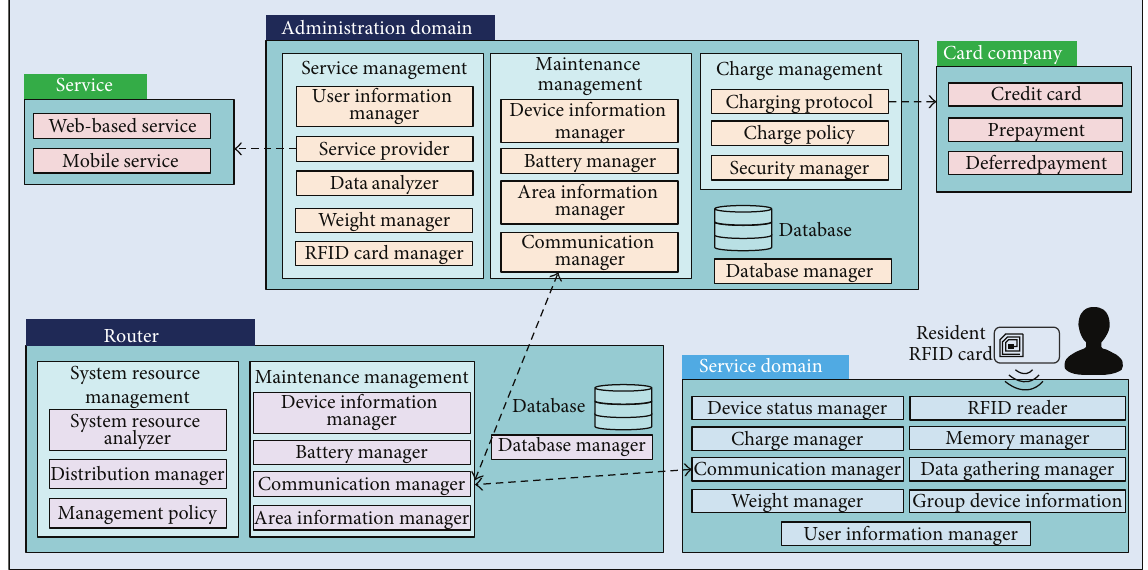
Figure 4: Middleware architecture of the proposed smart garbage